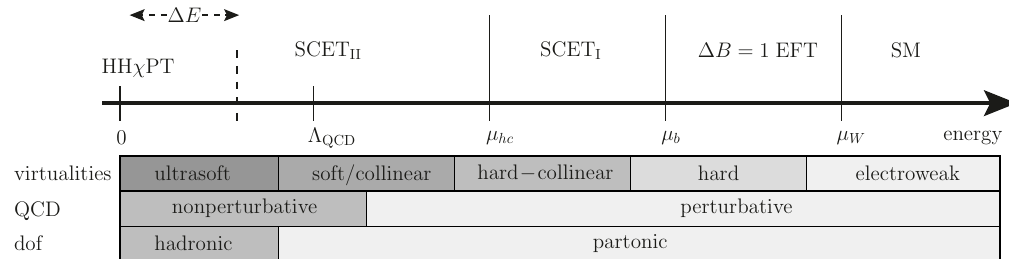
Figure 1. Scheme of the multiple scales and the respective tower of e(cid:11)ective theories applicable to B q ‘ + ‘ (cid:0) transitions and more generally also other b -hadron decays. See text for more ! explanations. The range of (cid:1) E is indicated for the case (cid:1) E